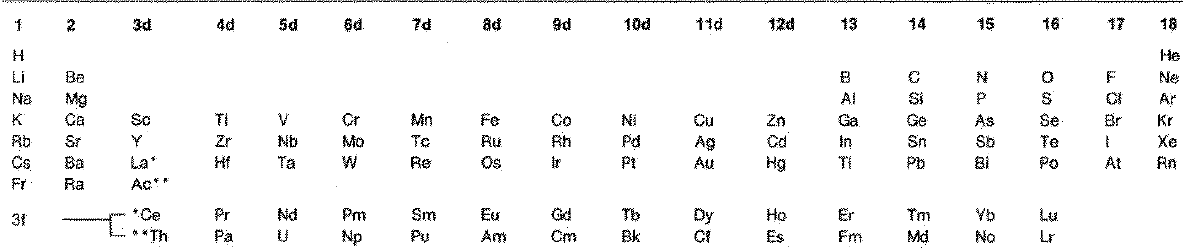
Figure 9. Periodic Table recommended by the ACS in 1984 (Courtesy of the American Chemical